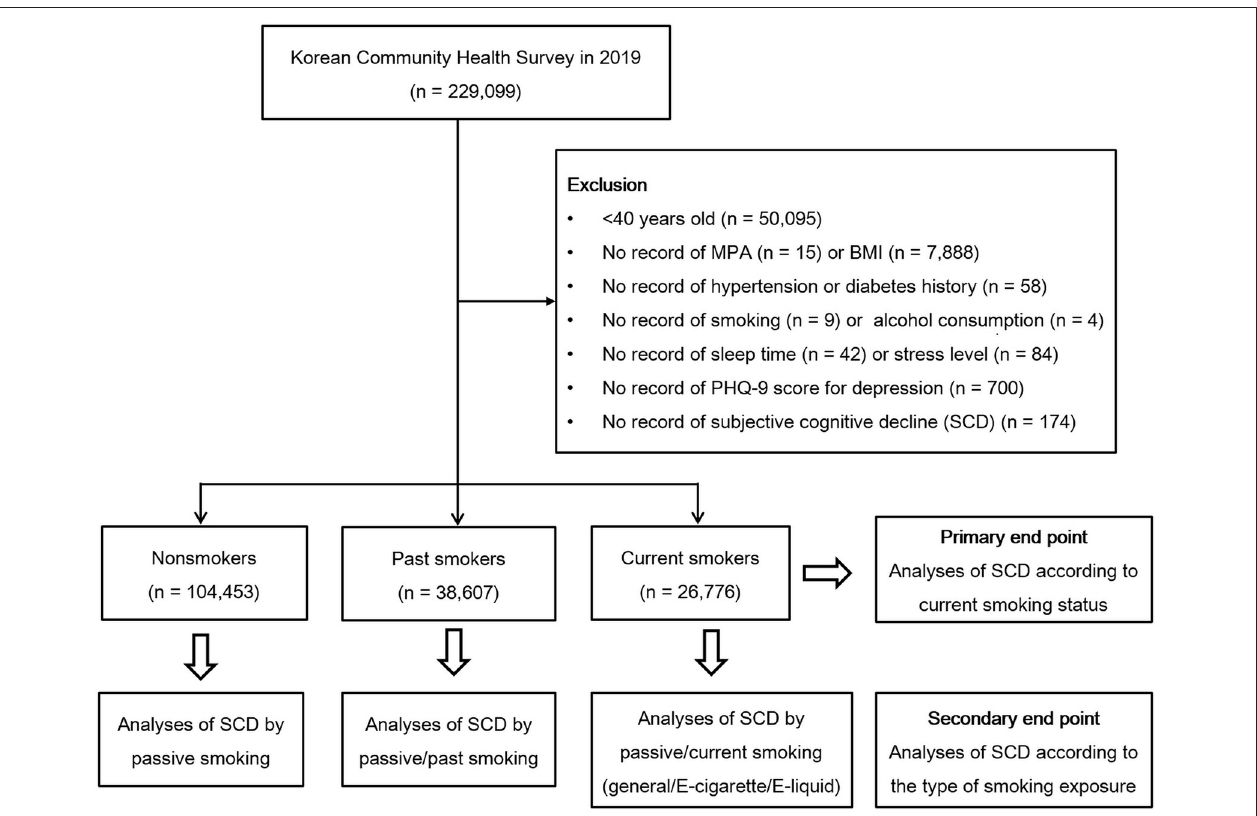
FIGURE 1 | A schematic illustration of the participant selection process used in this study. A total of 104,453 nonsmokers, 38,607 past smokers, and 26,776 current smokers according to current smoking status were included in the